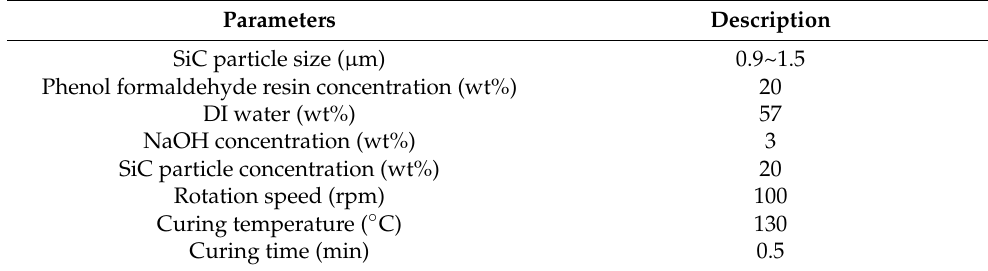
Table 4. Constant parameters and setting values of the EPD experiments.